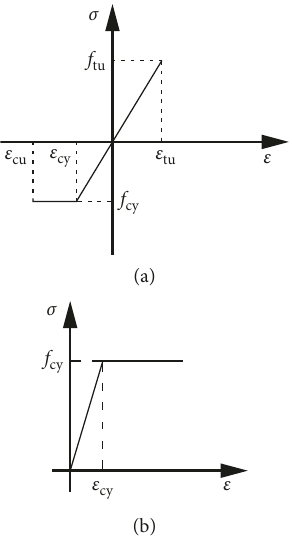
Figure 10: Simplified constitutive model of timber. (a) Parallel to the grain; (b) compression in radial